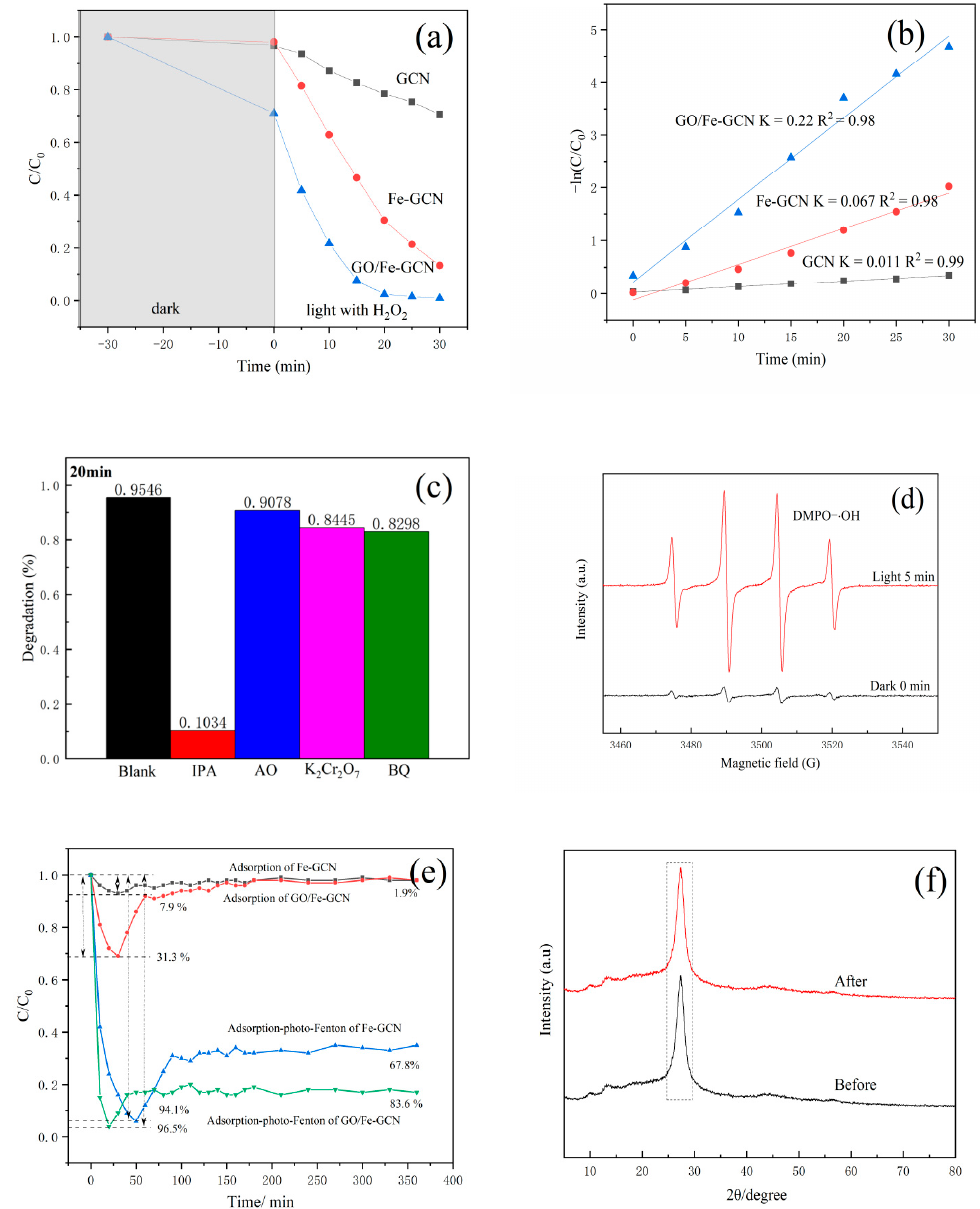
Figure 7. The photo-coordinated Fenton degradation efficiencies of GCN, Fe-GCN, and GO/Fe-GCN ( a ). The quasi-first-order reaction kinetic rate of GCN, Fe-GCN, and GO/Fe-GCN ( b ) under photo-coordinated Fenton degradation. The various captured agents with the inhibitory effect on the degradation reaction ( c ) and electron paramagnetic resonance (EPR/ESR) ( d ) for GO/Fe-GCN. The dynamic adsorption and synergy effect of adsorption- photo-coordinated Fenton degradation on the dynamic system of samples ( e ). XRD pat-terns of GO/Fe-GCN before and after the adsorption–photo-coordinated Fenton degradation process ( f ).